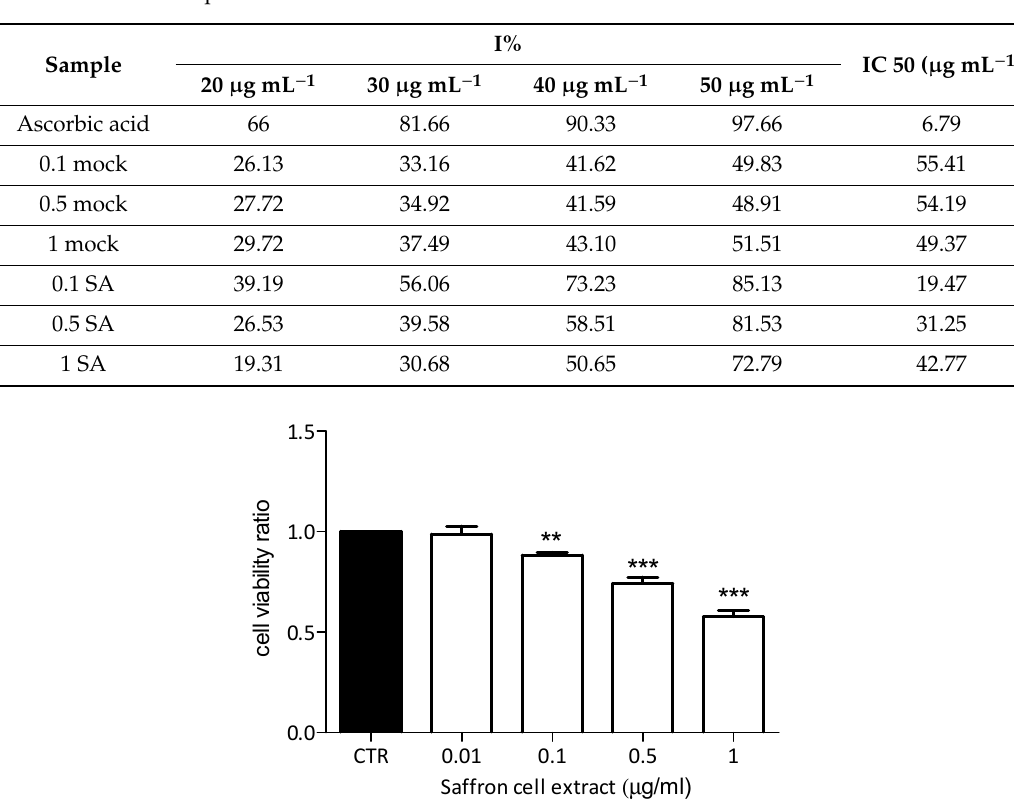
Figure 7. Antioxidant activity of methanol:water extracts of sa ff ron in mock and SA (mM) treated cells intra (cells) and extracellularly (spent medium) measured by; ( a ) Oxygen radical absorbance capacity (ORAC); ( b ) Trolox equivalent antioxidant capacity (TEAC) assays. Common letter in each group indicates no significant di ff erences ( p < 0.05). Table 1. Inhibition percentage (I %) and IC50 ( µ g mL − 1 ) of free radical scavenging activities from DPPH assay in sa ff ron mock and salicylic acid (SA) treated cells at di ff erent concentrations of both cell extracts and their spent media.